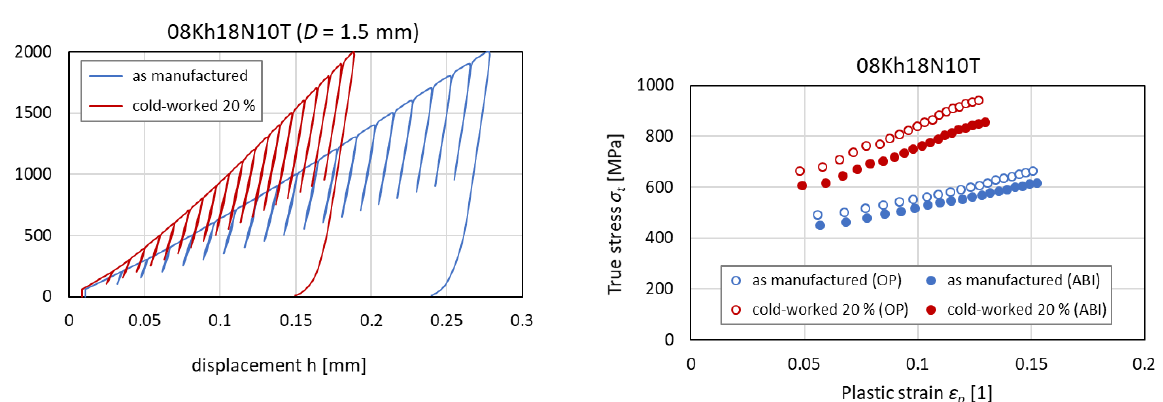
Figure 3. ABI test load - displacement curve for undeformed a cold deformed 08Kh18N10T steel.